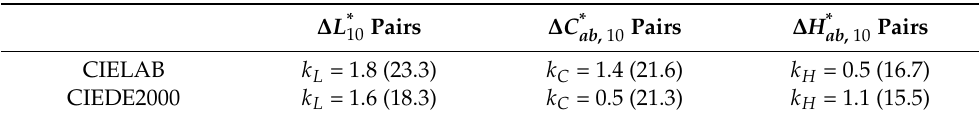
Table 5. The individual optimized k L , k C , k H factors and corresponding STRESS values (in parenthe- ses) for CIELAB and CIEDE2000, considering three kinds of color pairs in Experiment I.